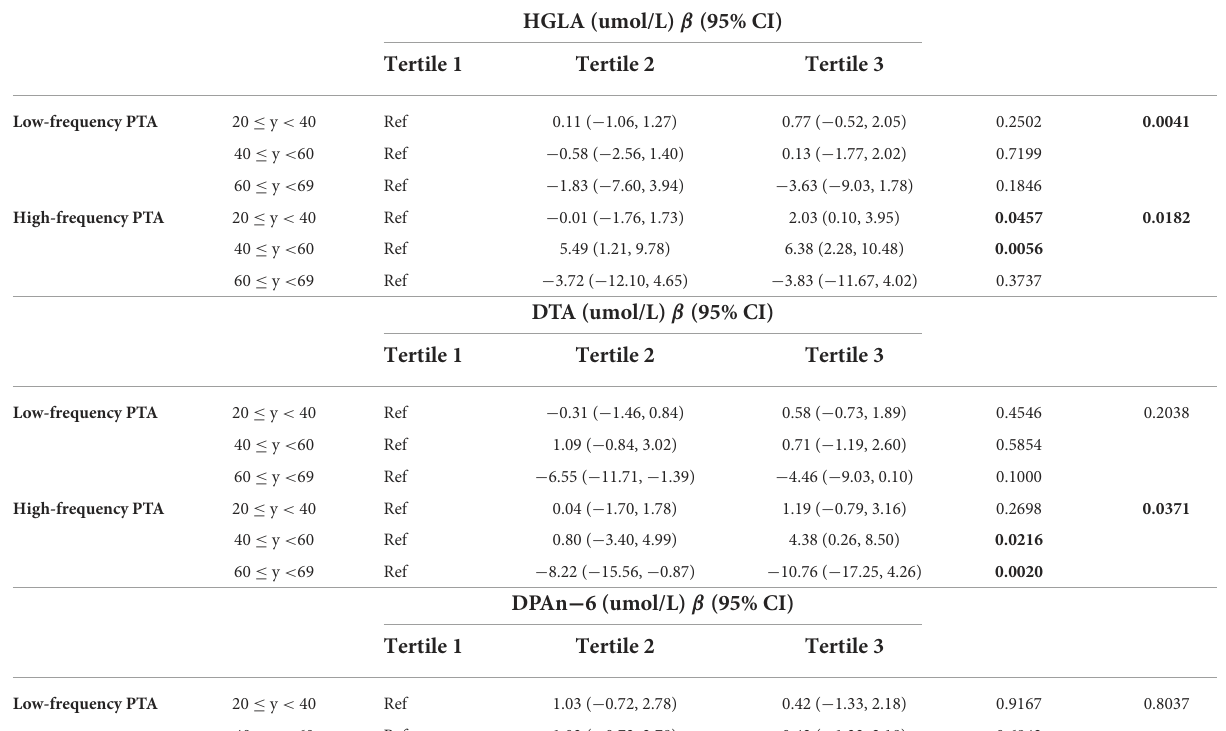
TABLE 3 Adjusted a associations between PUFAs and hearing threshold shifts stratified by age ( N = 913).